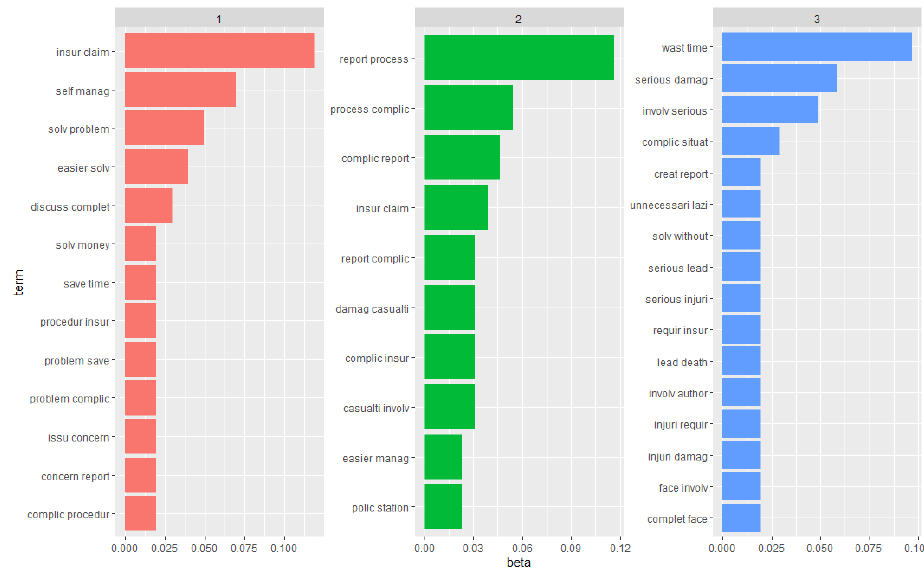
Fig. 1. The important bigrams for the three topics in Q2.